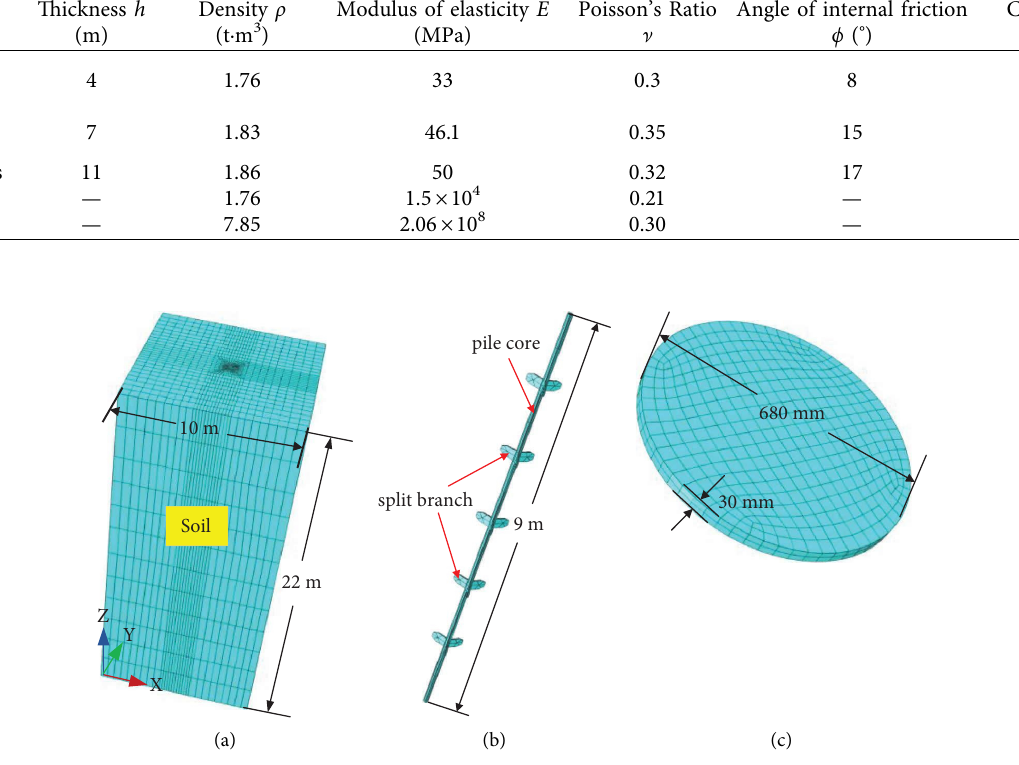
Figure 13: Finite Element Model: (a) soil model; (b) pile model; (c) bearing plate